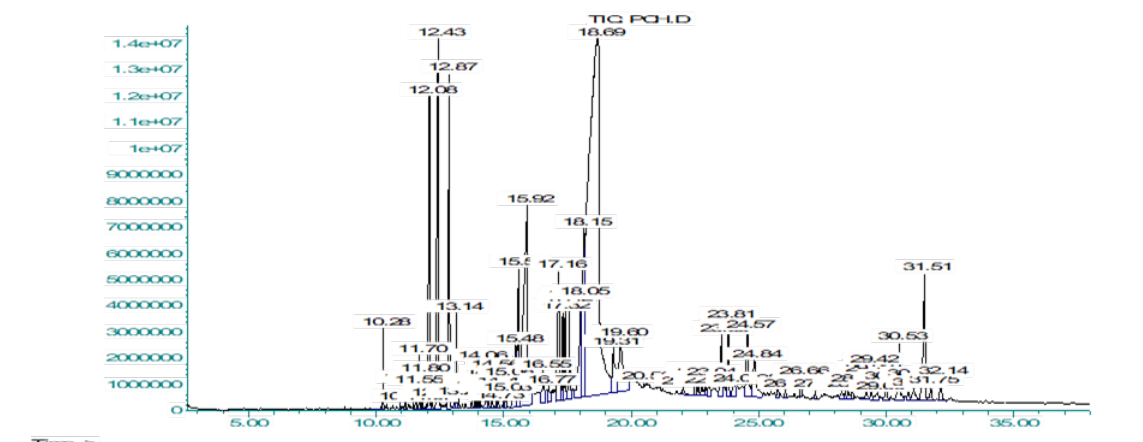
Figure 2 . Chromatogram obtained from GCMS analysis of PCHF. Figure 2. Chromatogram obtained from GCMS analysis of Table 3. Phytochemical profiling of n -hexane (PCHF) fraction of P.candollei through GCMS analysis. Sr.n